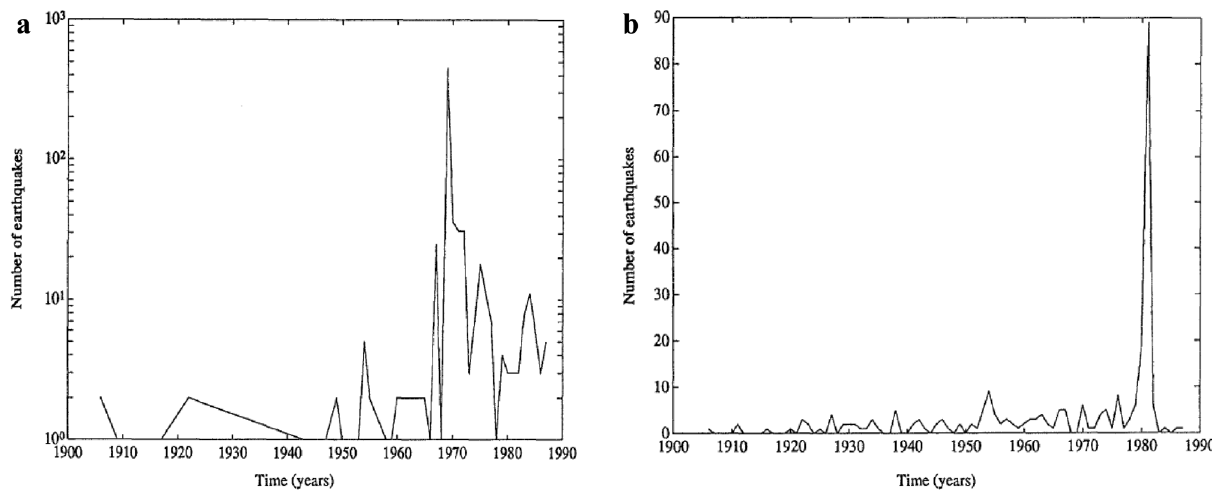
Fig. 1 Temporal annual variation of seismic activity, m ≥ 3.0, based on instrumental data: a Gulf of Suez; b other active zones in Egypt [9]